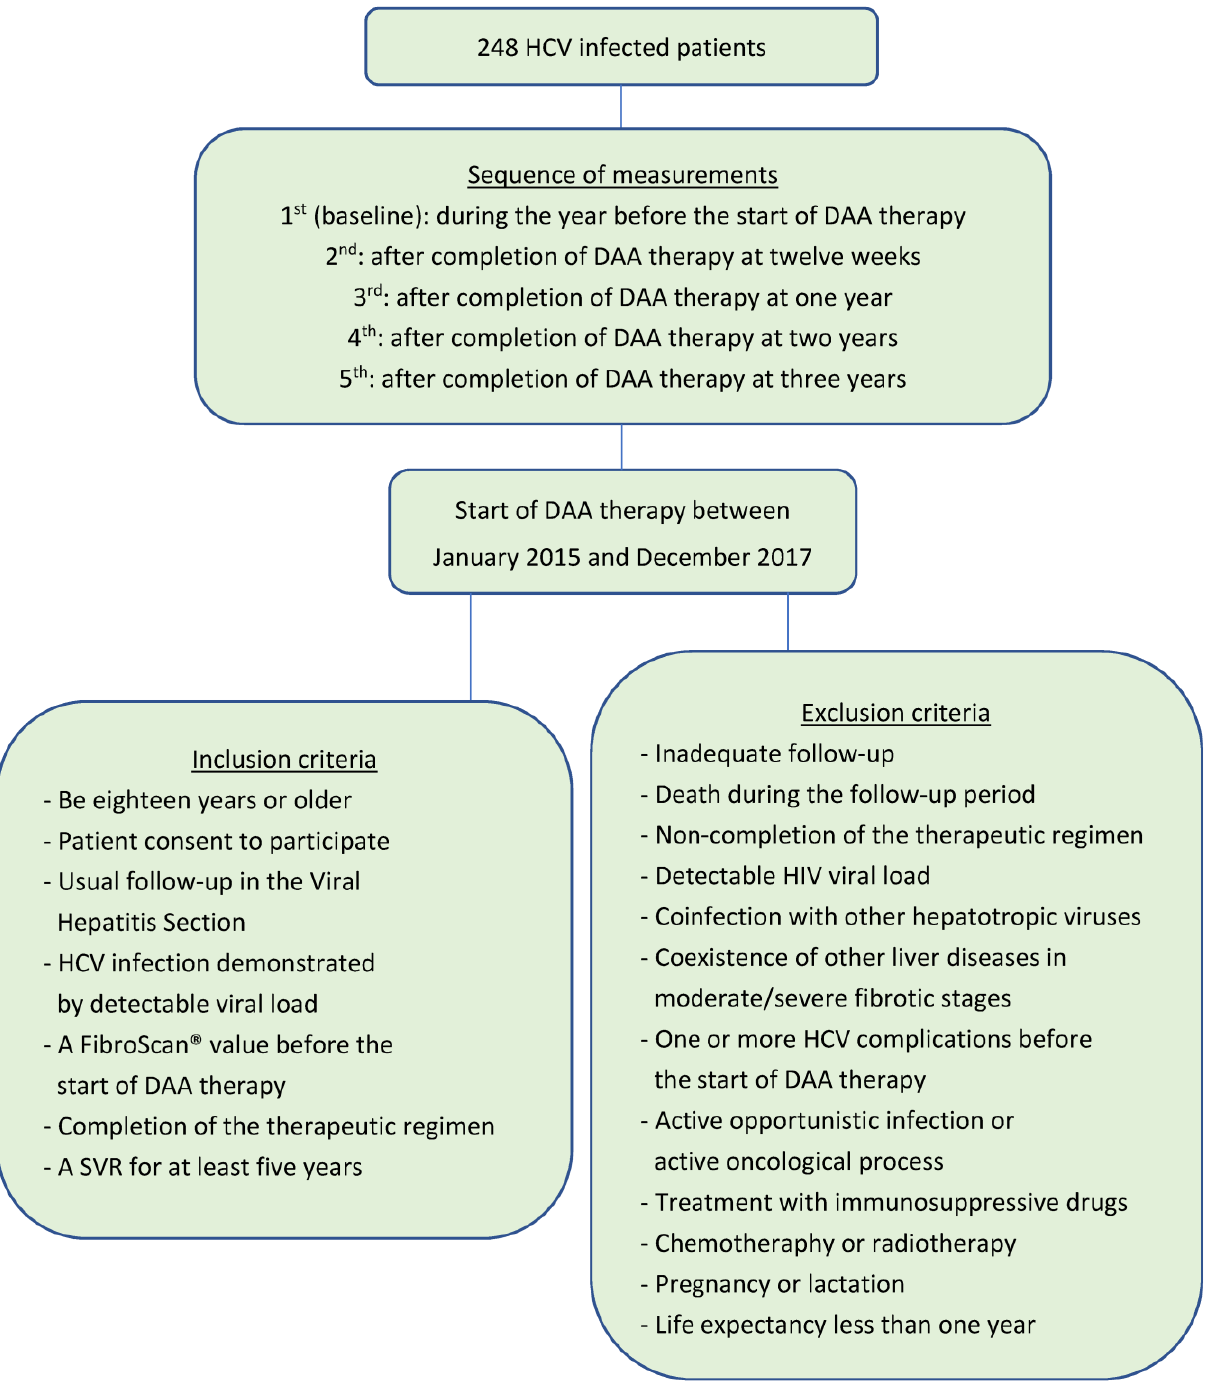
Figure 1. Study design (participants were enrolled until 31 December 2017 and were followed up until 31 December 2020). DAA, direct-acting antiviral; HCV, hepatitis C virus; HIV, human immunodeficiency virus; SVR, sustained virological response.